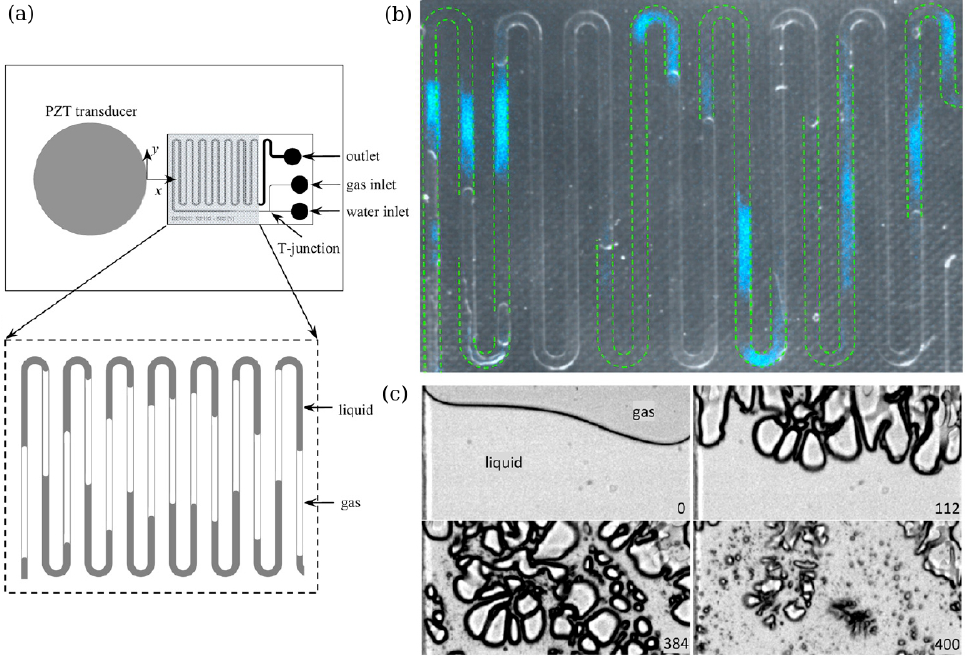
Figure 7. ( a ) Sketch of the microfluidic device designed in [26] to observe sonochemistry and sonolu- minescence effects. The piezoelectric transducer (PZT) used for the creation of the driving ultrasound wave is glued to a glass substrate to which a meandering microfluidic channel is bonded. The inlets consist of two ports for gas and water, respectively. The inset shows a typical distribution of gas and liquids along the microchannel. ( b ) Picture of the microfluidic channel geometry superimposed on a photograph showing sonochemiluminescence activity due to the oxidation of luminol. The green dashed lines indicate the positions of liquid slugs inside the channels just before the ultrasound was switched on. ( c ) Sequence of images taken with a high-speed camera showing the bubble distribution near a gas–liquid interface. The number in each frame is in microseconds after switching on the ultrasound signal. One can see that the initial gas–liquid interface leads to surface instabilities, expan- sions of large bubbles, and eventually, bubble collapses. The interface was exposed to a harmonic ultrasound driving wave with a frequency of 103.6kHz. The width of each frame is 500 µ m, which is also the width of the microfluidic channel. Reproduced from [26] under the exclusive PNAS License to Publish. Copyright 2011, National Academy of